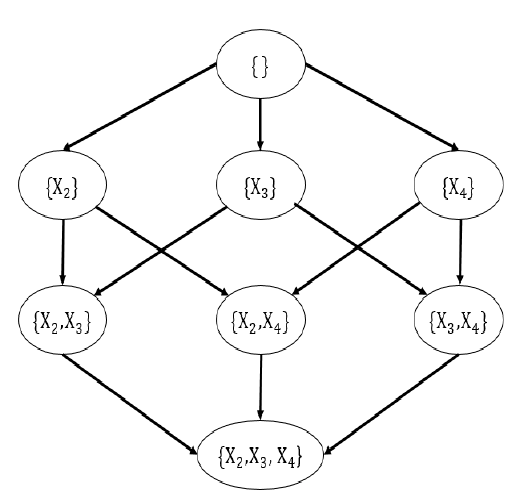
Figure 5. The parent graph of node X 1